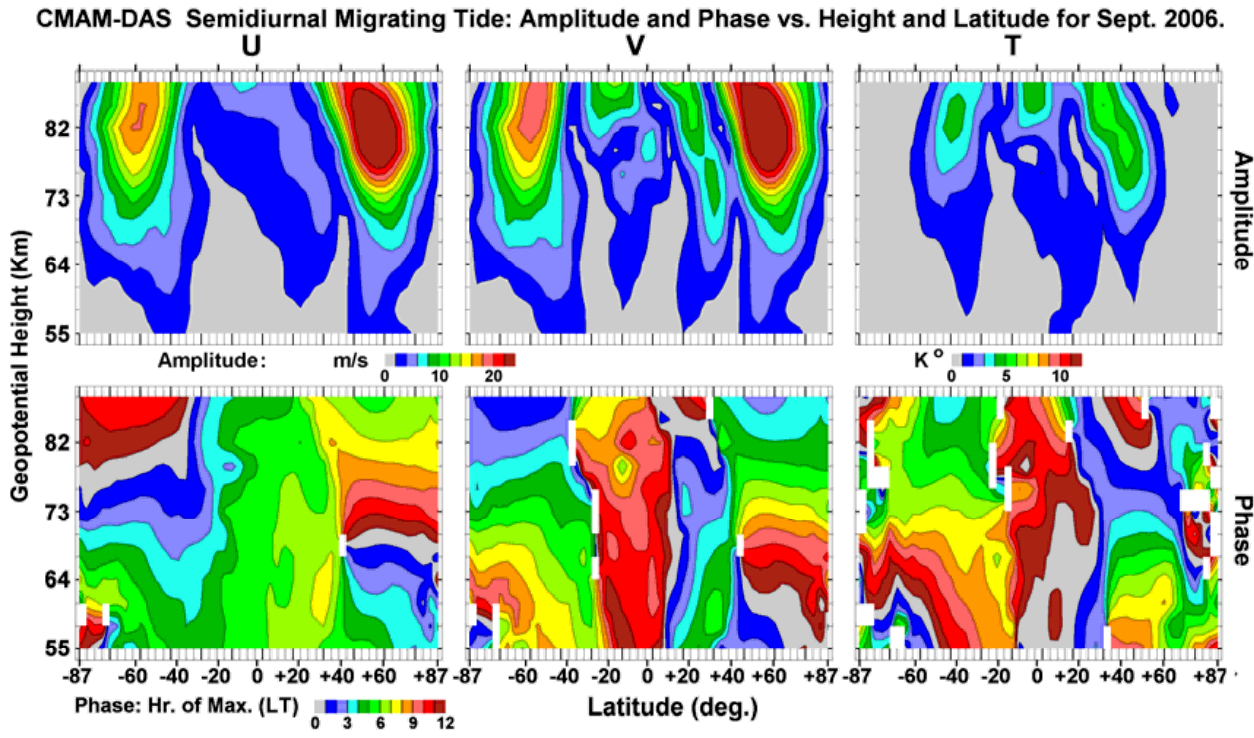
Fig. 3. Contour-plots of amplitudes and phases of the migrating ( s =2) semidiurnal tide [meridional and zonal wind components, and temperature] as functions of height and latitude: data for September 2006 from the model CMAM-DAS have been used.